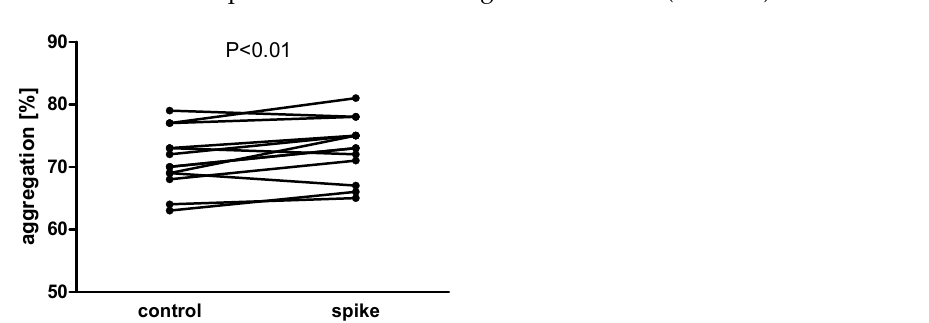
(n = 6). Representative images of platelets stained against CD41. Statistical significance of differences between control vs. spike sample was estimated with the Wilcoxon signed-rank test.